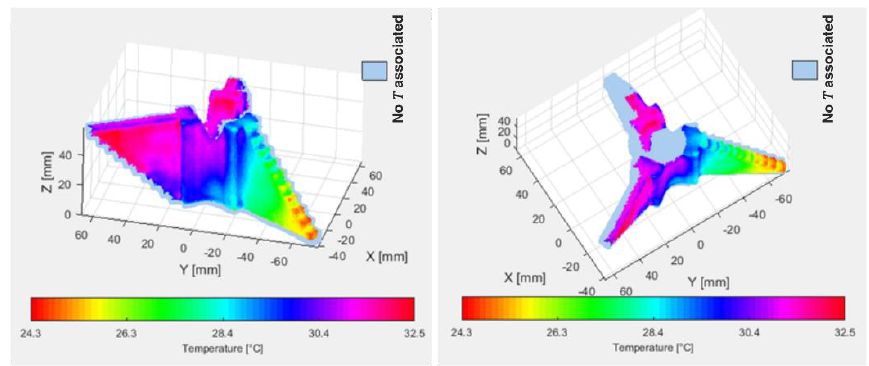
Figure 12. Two different views of the result of the integration of thermogram B on the point cloud. Appl. Sci. 2020 , 10 , 828